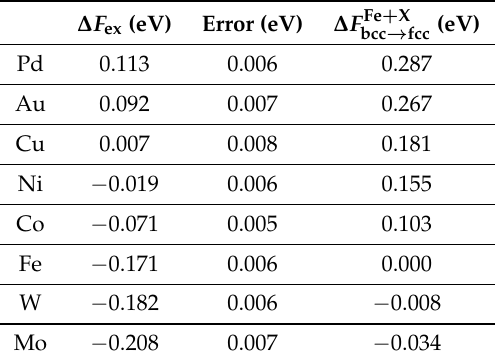
Table 1. Difference between the fcc and bcc energies caused by the exchange of an Fe atom by an alloying atom, ∆ F ex , Equation (3), and free-energy difference between the bcc and fcc structures in the alloy, ∆ F Fe + X , Equation (4), at a temperature of 1183 K and a concentration of 0.39 bcc → fcc